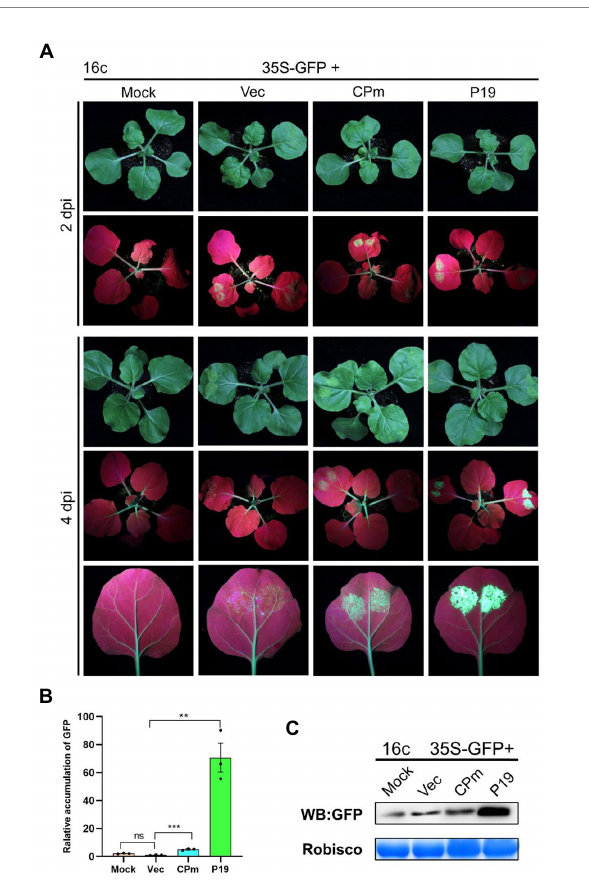
FIGURE 4 Tomato chlorosis viru s CPm protein suppressing local RNA silencing triggered by GFP ssRNA. (A) Photographs taken under the white light and UV light of Nicotiana benthamiana 16c leaves at 2 and 4 days post-infiltration (dpi) with Agrobacterium tumefaciens harboring 35S-GFP, either in combination with the pBIN19-3HA empty vector (Vec), or with constructs expressing CPm or P19 . (B) Relative mRNA levels of GFP were measured by RT-qPCR. (C) Western blotting analysis of GFP protein extracted from the zones infiltrated with Agrobacterium tumefaciens harboring the constructs indicated above each lane at 4